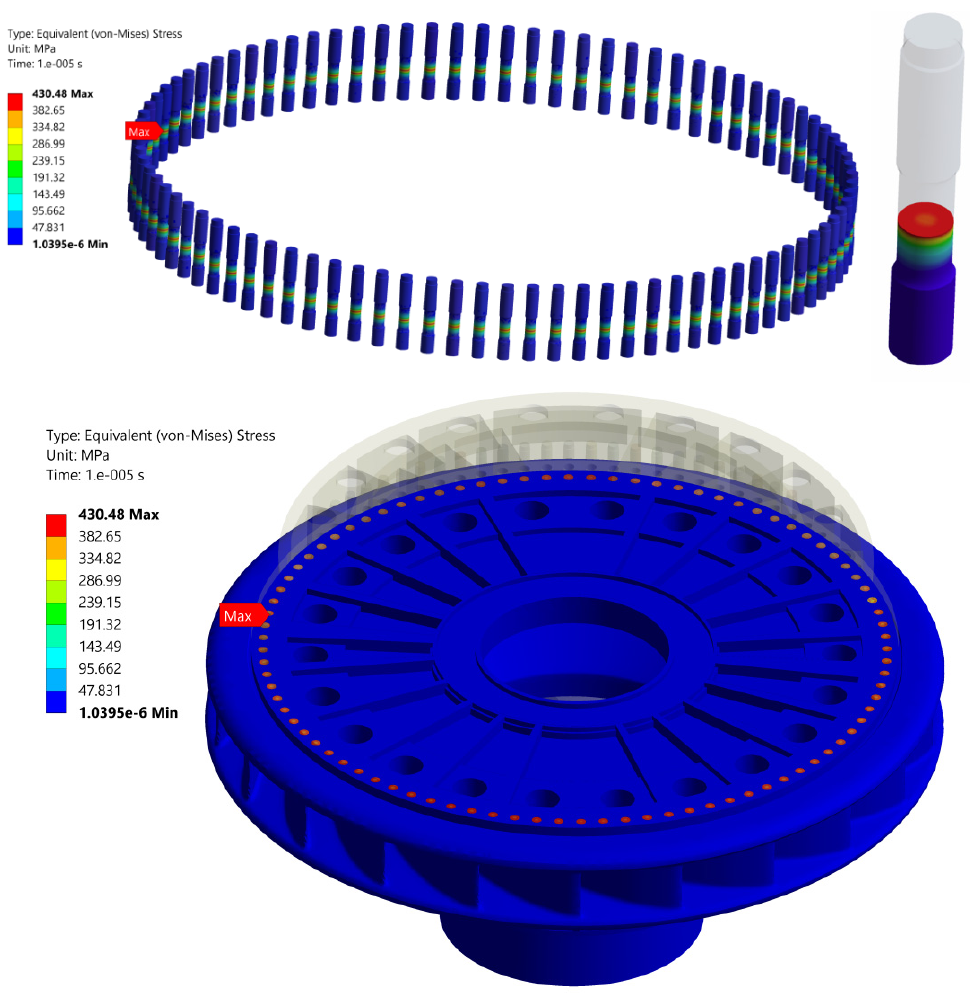
Figure 21. Stress distribution of the head-cover bolts under preload.